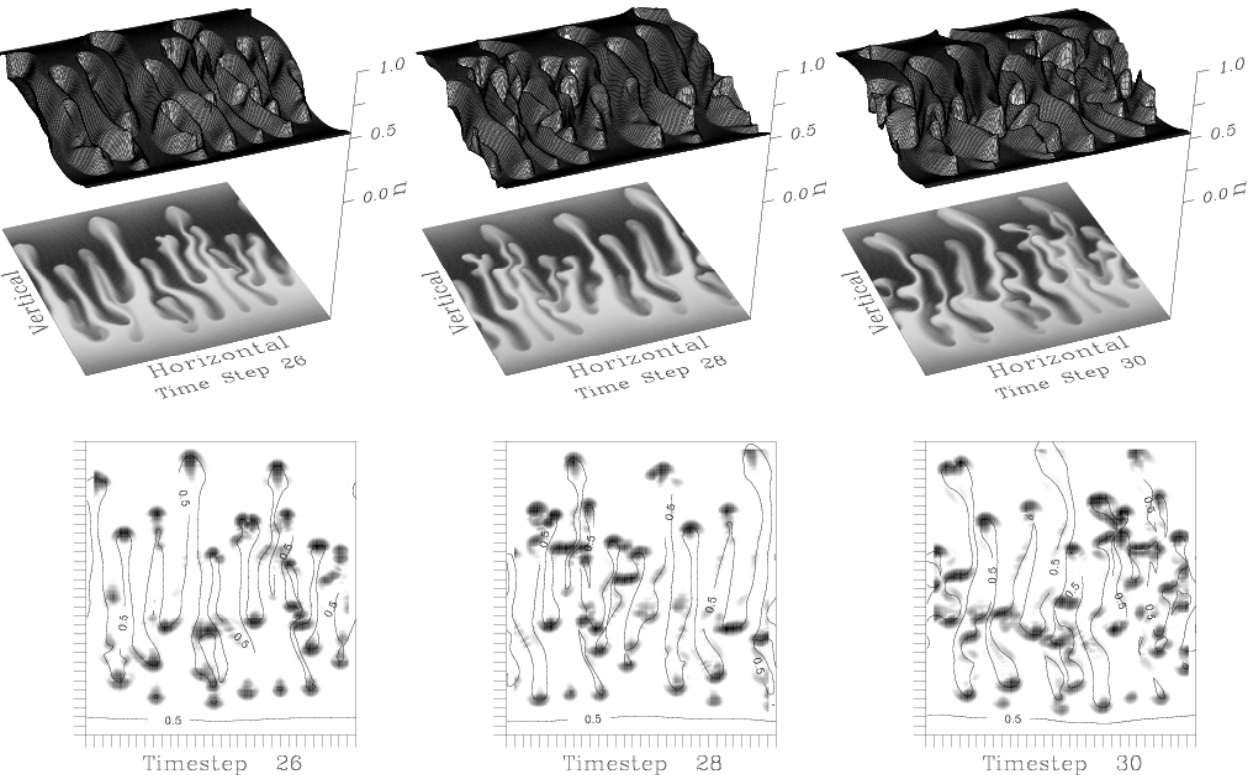
Fig. 10. Medium scale simulation of an interchange instability driven by gravity and a zonal electric field. Notice the teardrop formations